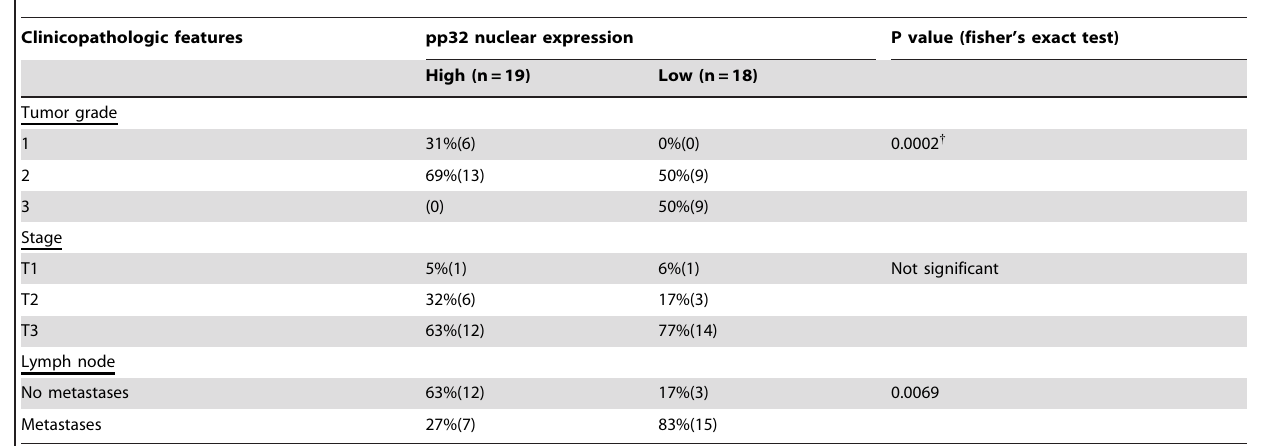
Table 2. Association of pp32 nuclear expression with clinicopathologic features.